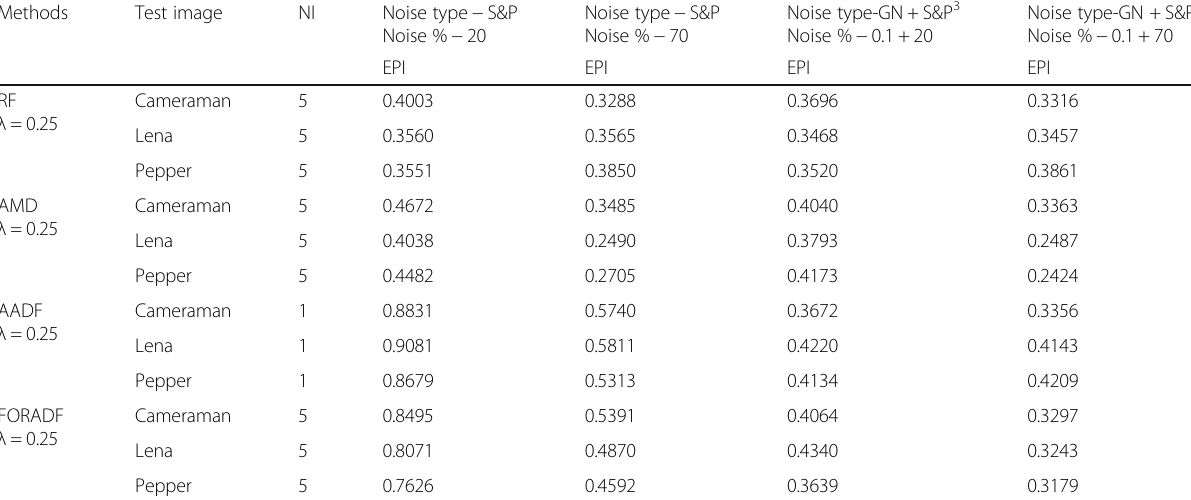
Table 4 Edge Preservation Index (EPI)